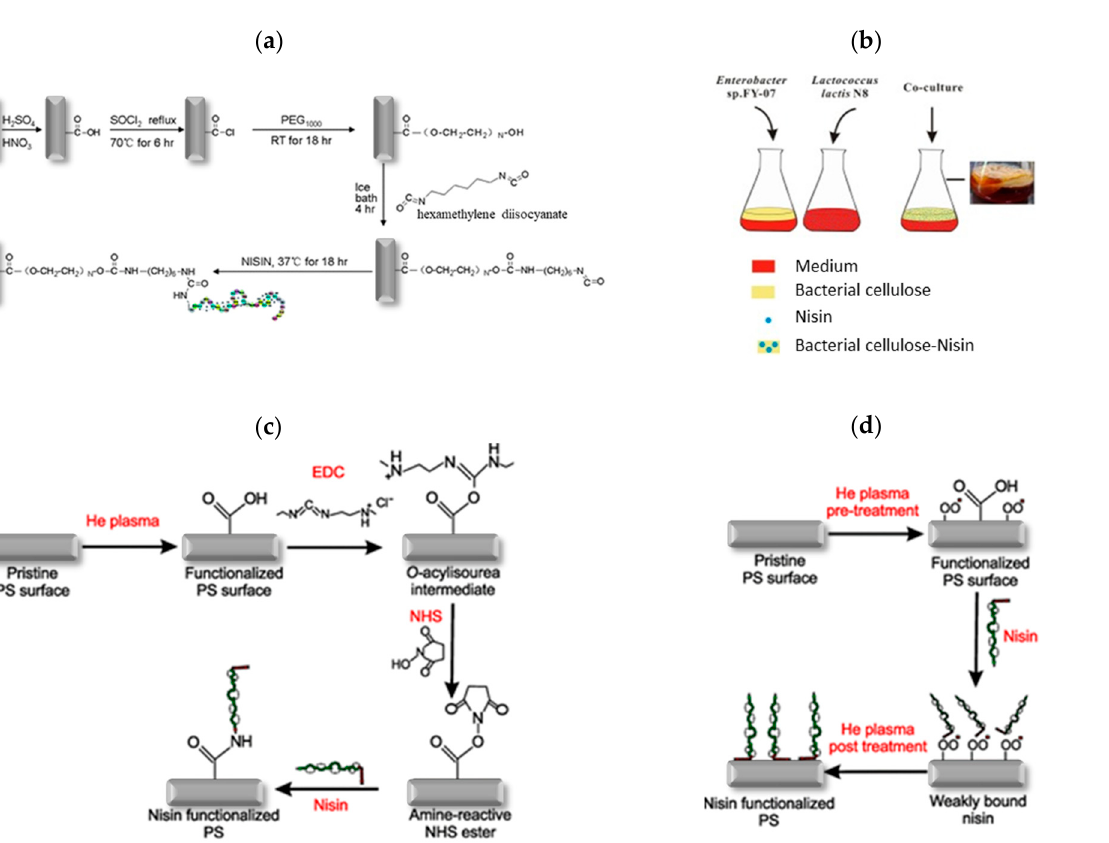
Figure 11. Schematic illustration of immobilization methods of nisin: ( a ) covalent immobilization onto multi-walled carbon nanotubes with PEG 1000 as a linker and hexamethylene diisocyanate as a crosslinking agent (Adopted with permission from [176], RSC, 2011); ( b ) co-culture fermentation of nisin-producing ( Lactococcus lactis N8) and bacterial cellulose-producing ( Enterobacter sp. FY-07) bacteria (Adopted with permission from [153], Elsevier, Amsterdam, The Netherlands, 2021); ( c ) covalent immobilization onto plasma-treated, EDC/NHS ester functionalized polystyrene sheets (Adopted with permission from [138], RSC, 2017); ( d ) covalent immobilization onto plasma-treated polystyrene sheets (Adopted with permission from [138], RSC, 2017); ( e ) nisin loaded chitosan-poly- γ -glutamic acid nanoparticles (encapsulation) (Reproduced with permission from [179], RSC, Cambridge, UK, 2016); ( f ) adsorption of nisin on blank and HGFI-coated polystyrene surface together with antimicrobial activity of both surfaces (Adopted with permission from [9], Elsevier, Amsterdam, The Netherlands, 2021).